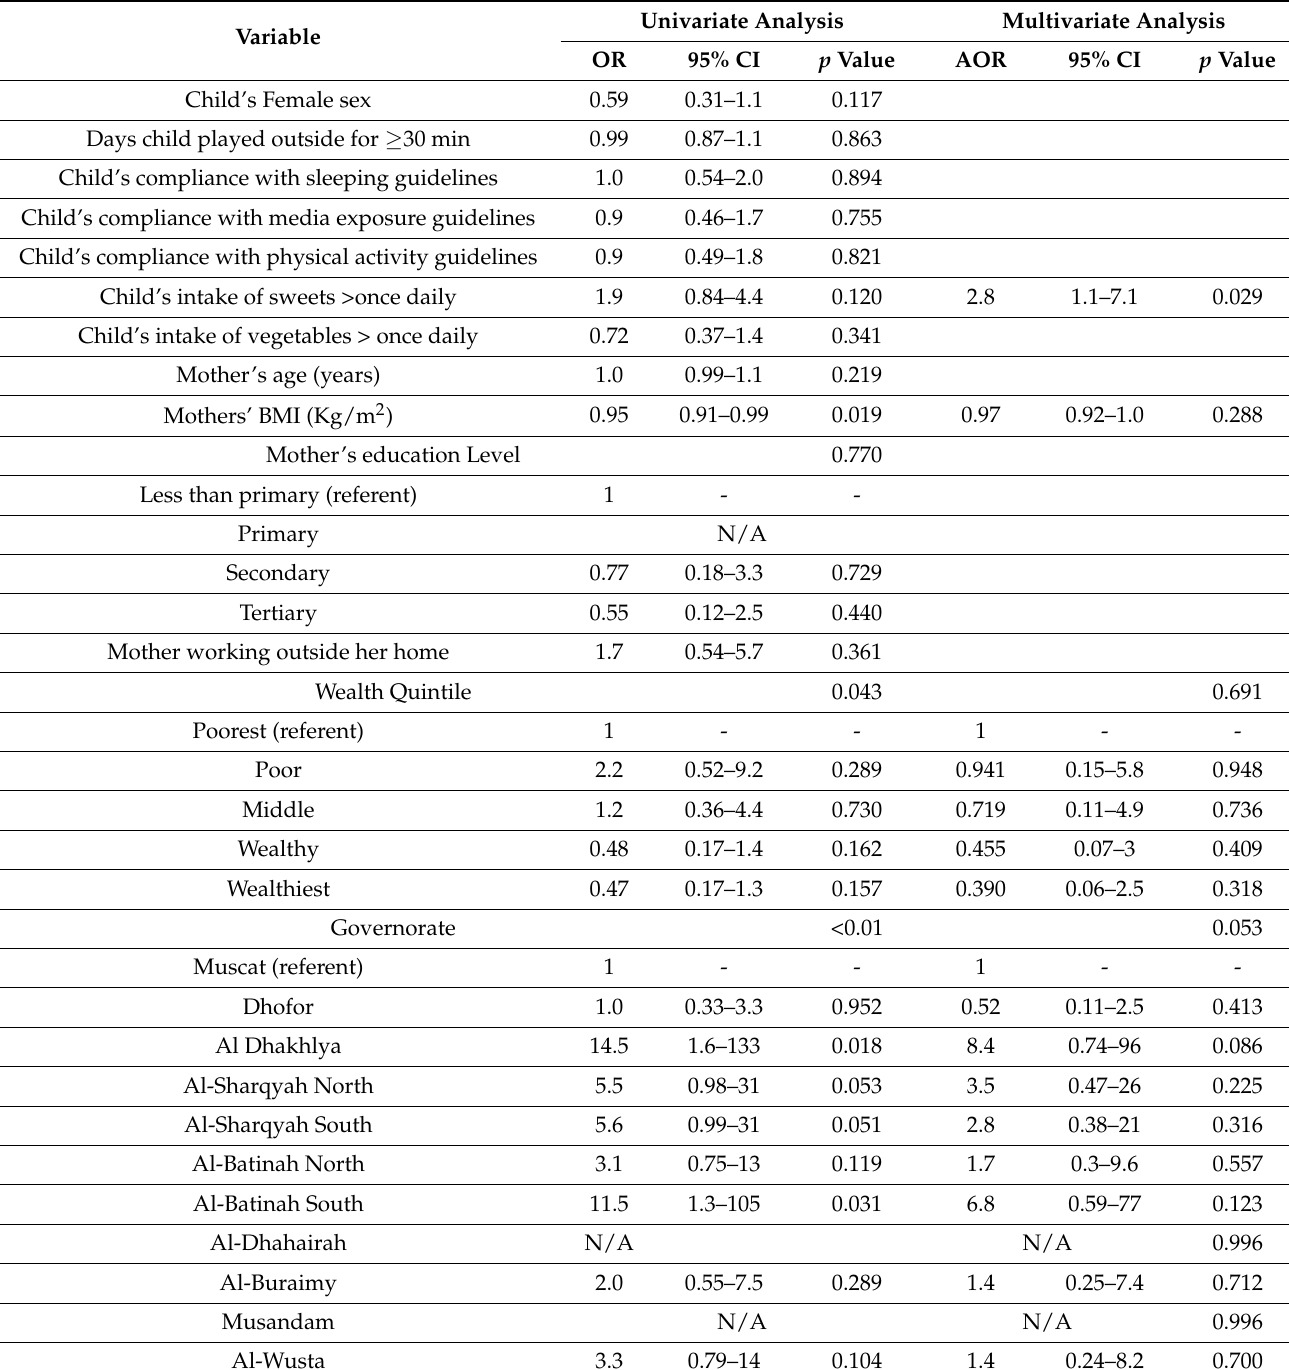
Table 3. Logistic Regression of children being in the overweight or obese